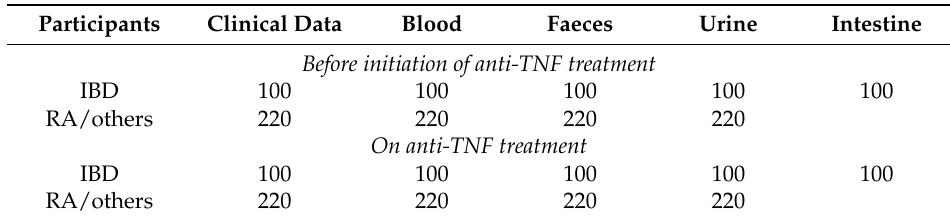
Table 1. Participant samples available for the study.